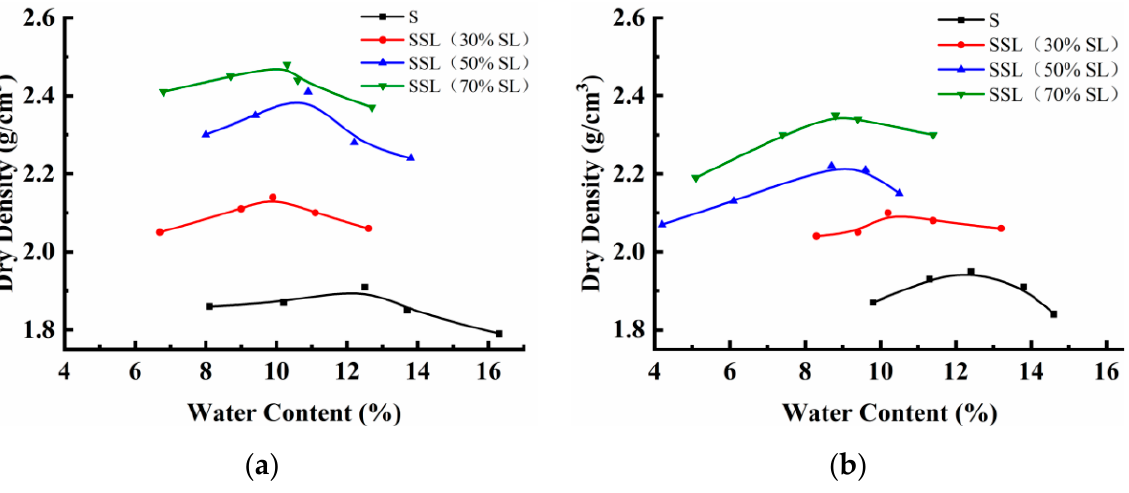
Figure 6. The compaction test results: ( a ) compaction curves of specimens from S1; ( b ) compaction curves of specimens from S2.